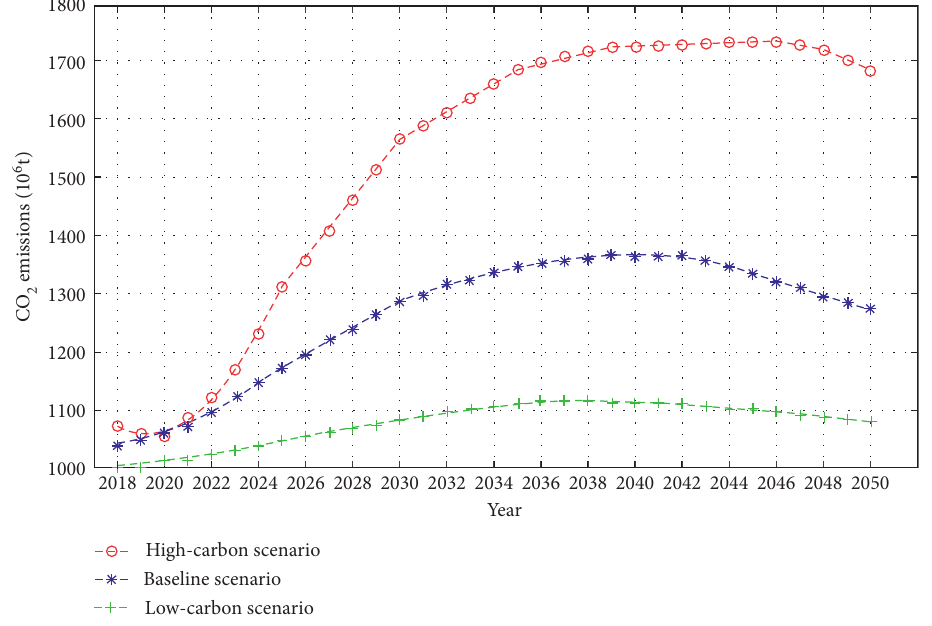
Figure 7: The trend of prediction results of carbon dioxide emissions under three scenarios.